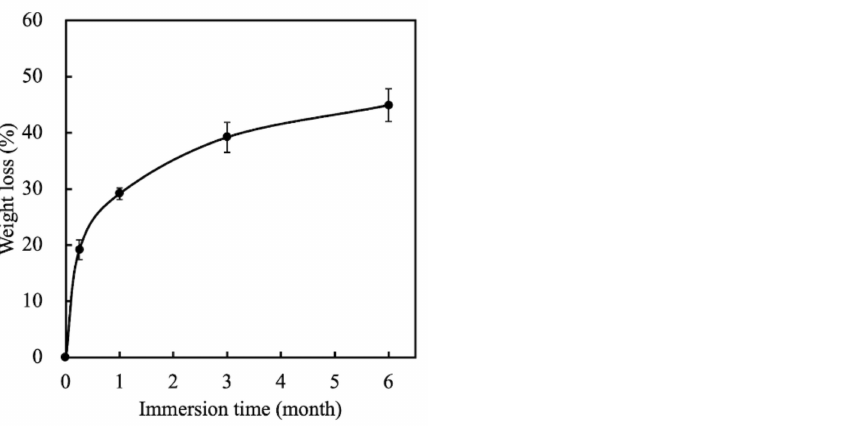
Figure 3. The weight loss of MS/CS scaffolds after soaking in SBF for various time periods.